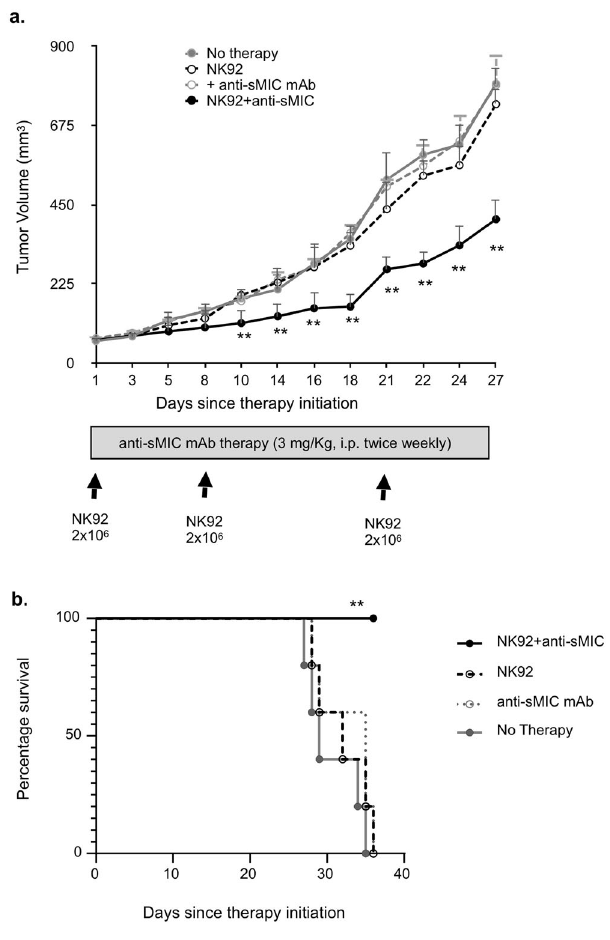
Fig. 7 Co-administration of sMIC-clearing nonblocking antibody effectuate NK92 cells controlling the growth of MIC + tumors in vivo.